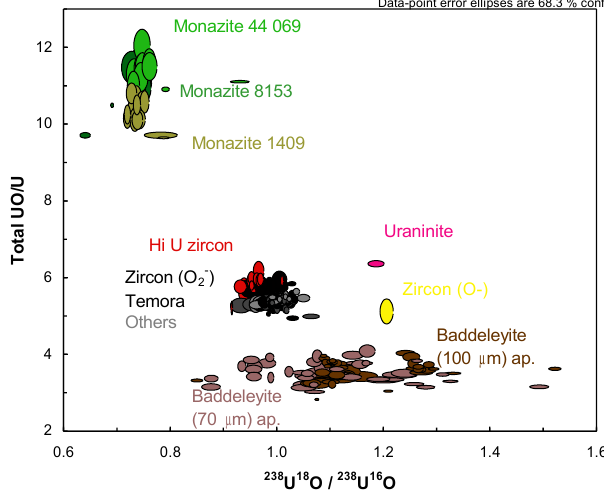
Data-point error ellipses are 68.3 % conf .